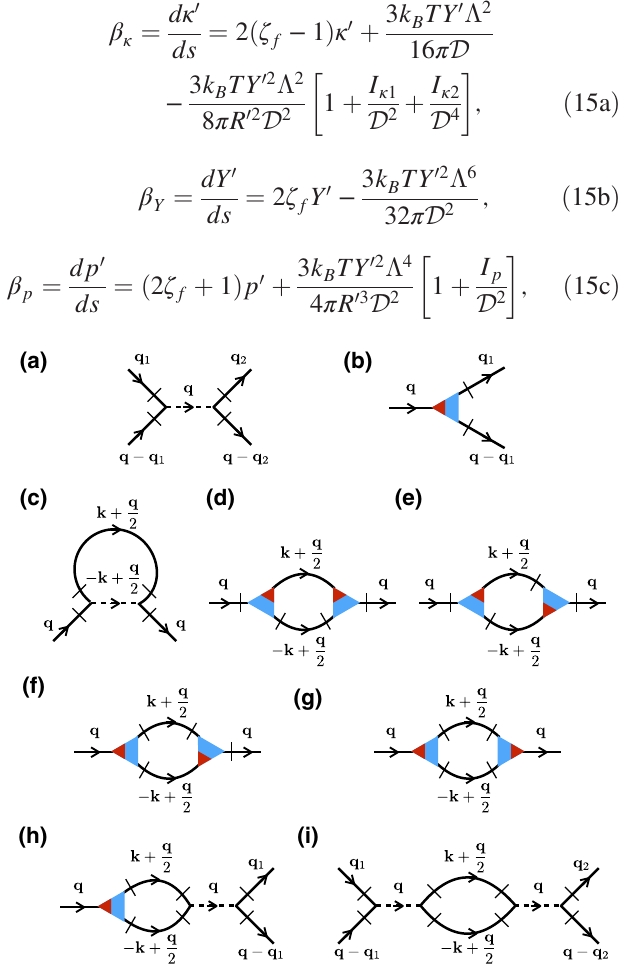
FIG. 2. Feynman diagrams contributing to the renormalization flows of Eq. (15). (a) Four-point and (b) three-point vertices describe the quartic and cubic terms in the free energy, Eq. (7b). ~ f ð q Þ , and slashes on Legs represent radial displacement fields legs correspond to spatial derivatives, which lead to additional factors of wave vectors in the Fourier space. The red part of the three-point vertex in (b) connects to a field without a slash, while the blue parts connect to derivative terms. The four-point vertex carries a factor Y , while the three-point vertex carries a factor Y=R . (c – i) One-loop diagrams that contribute to the renormal- ization flows of (c – g) the bending rigidity κ , (f – g) the external R pressure p , and (g) the Young ’ s modulus Y in the propagator R R q Þ in Eq. (9). Diagrams (h) and (i) describe one-loop G ff ð contributions to the renormalization flows of the Young ’ s modulus Y associated with three-point and four-point vertices, R respectively. The connected legs in these diagrams represent the q Þ , with wave vectors k restricted to the propagators G ff ð momentum shell Λ =b < k < Λ